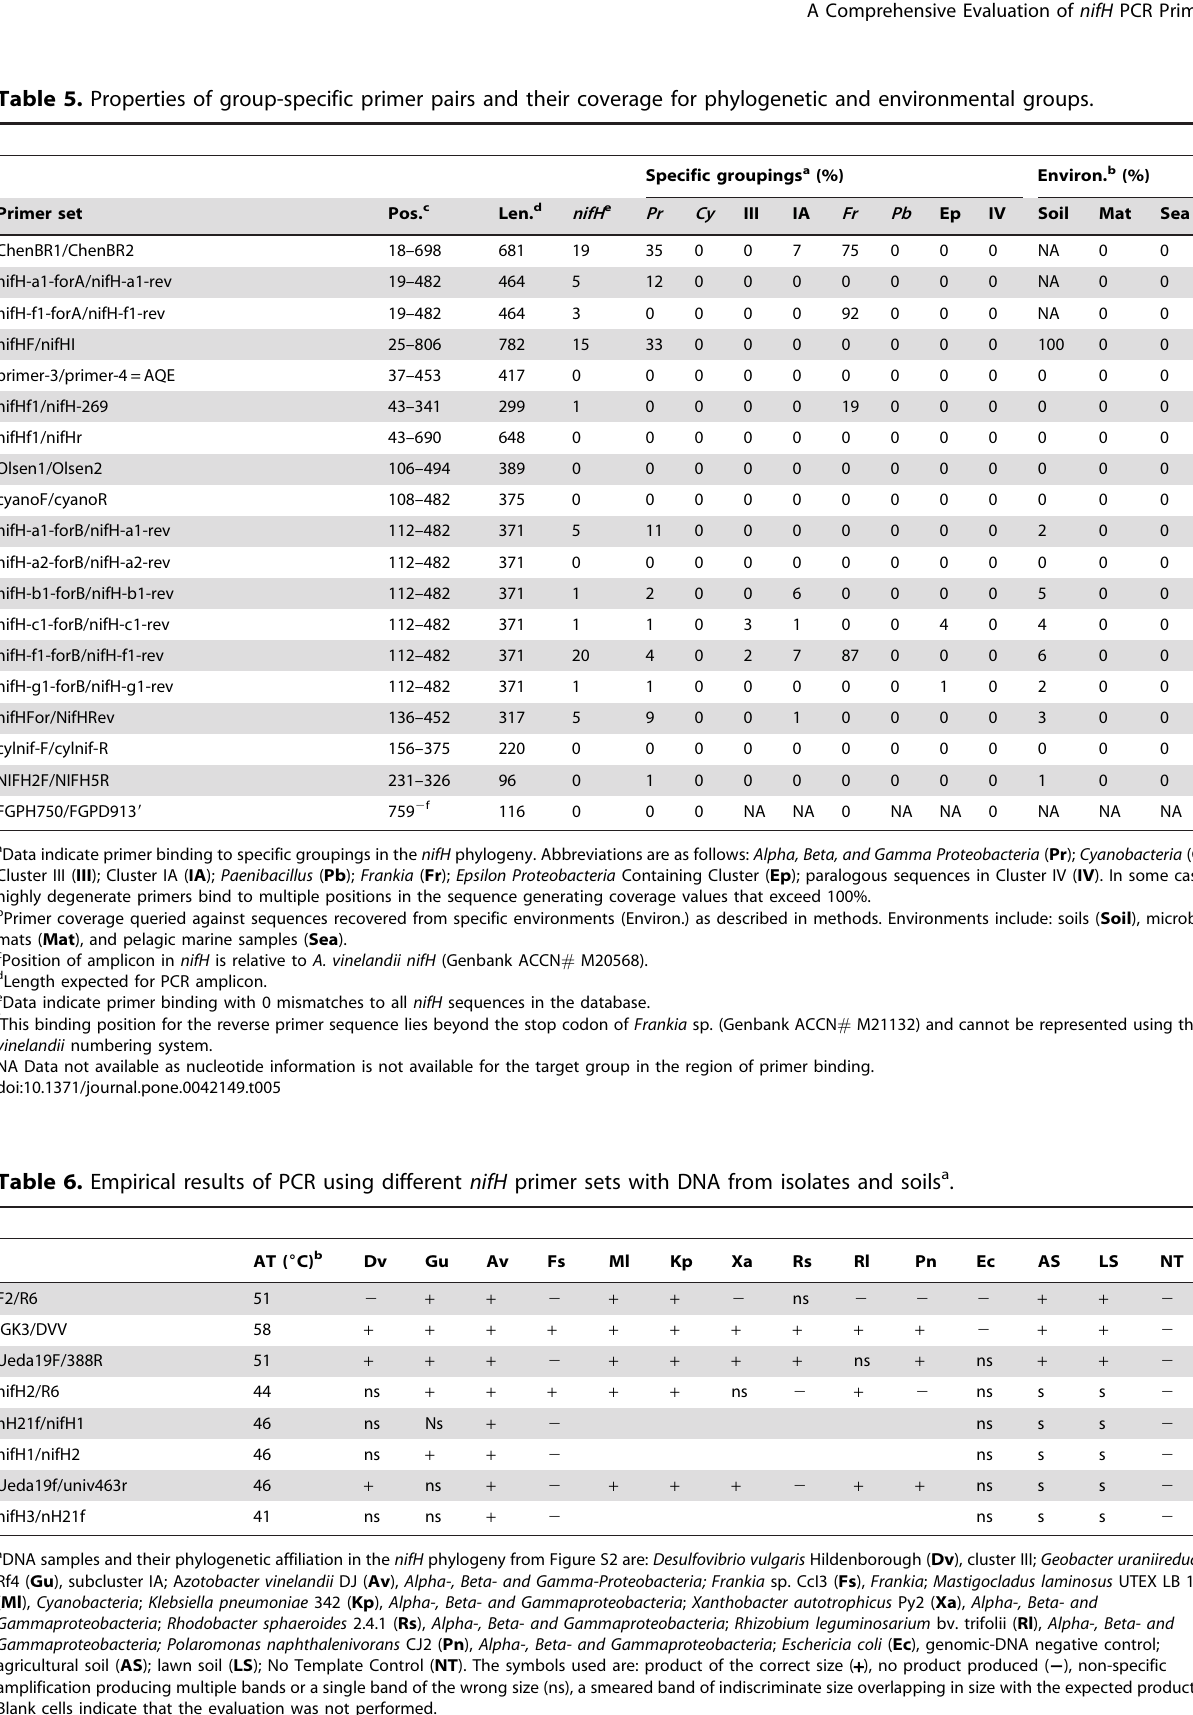
Table 5. Properties of group-specific primer pairs and their coverage for phylogenetic and environmental groups.